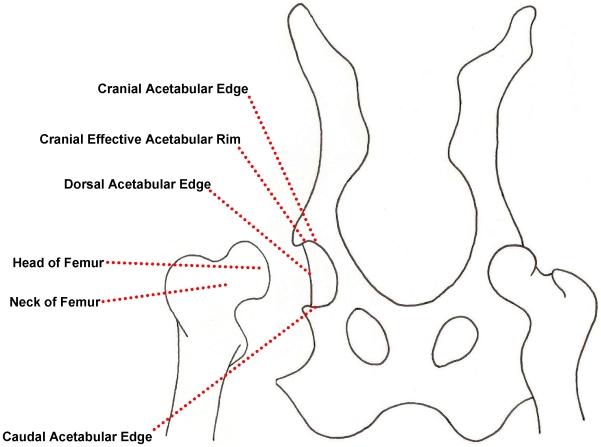
Diagrammatical representation of the skeletal features of the hip joint.Features pertinent to those graded by the BVA/KC hip score scheme.